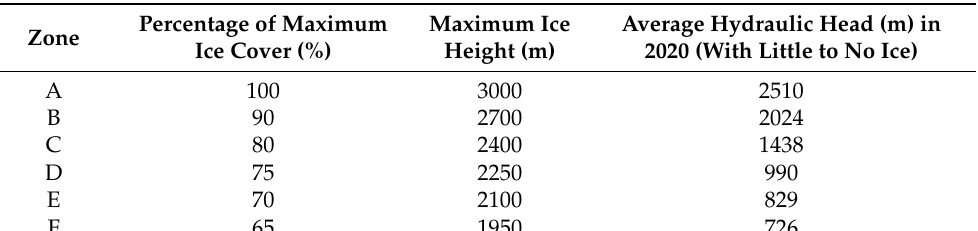
Table 3. Setting time variable boundary conditions for hydraulic head in the 6 zones indicated in Figure 10.